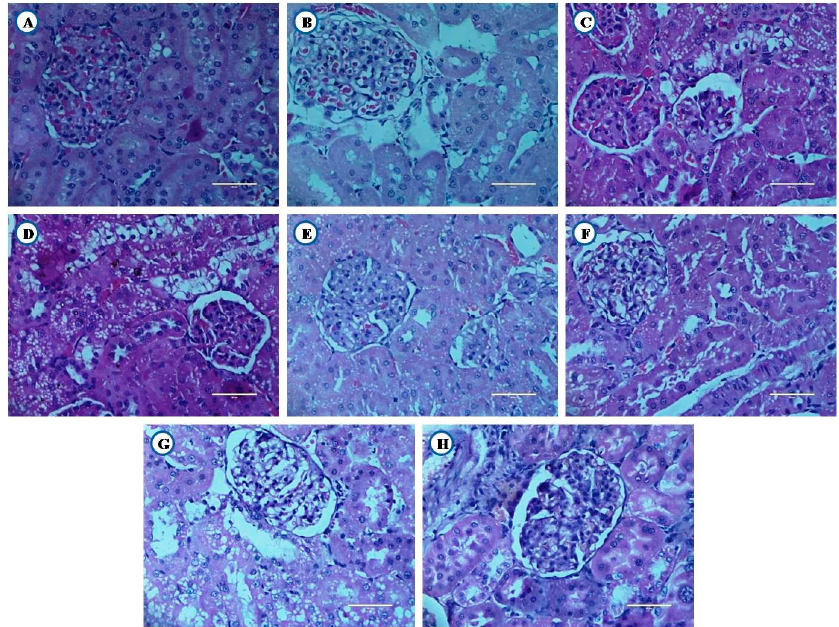
Figure 12. Histological examination of kidney (Scale bar 50 µ m). ( A ) Healthy control, ( B ) High fat diet control, ( C ) Diabetic control, ( D ) Glibenclamide control, ( E ) Statin control, ( F ) Glibenclamide statin control, ( G ) Flax oil (500 mg/kg), ( H ) Flax oil (500 mg/kg).